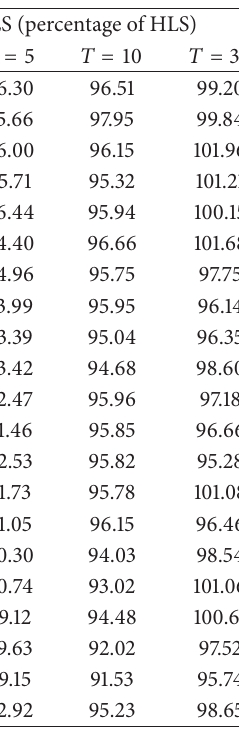
Table 6: Comparison between HLS and TOHLS when 𝑅 = 5000 (m).